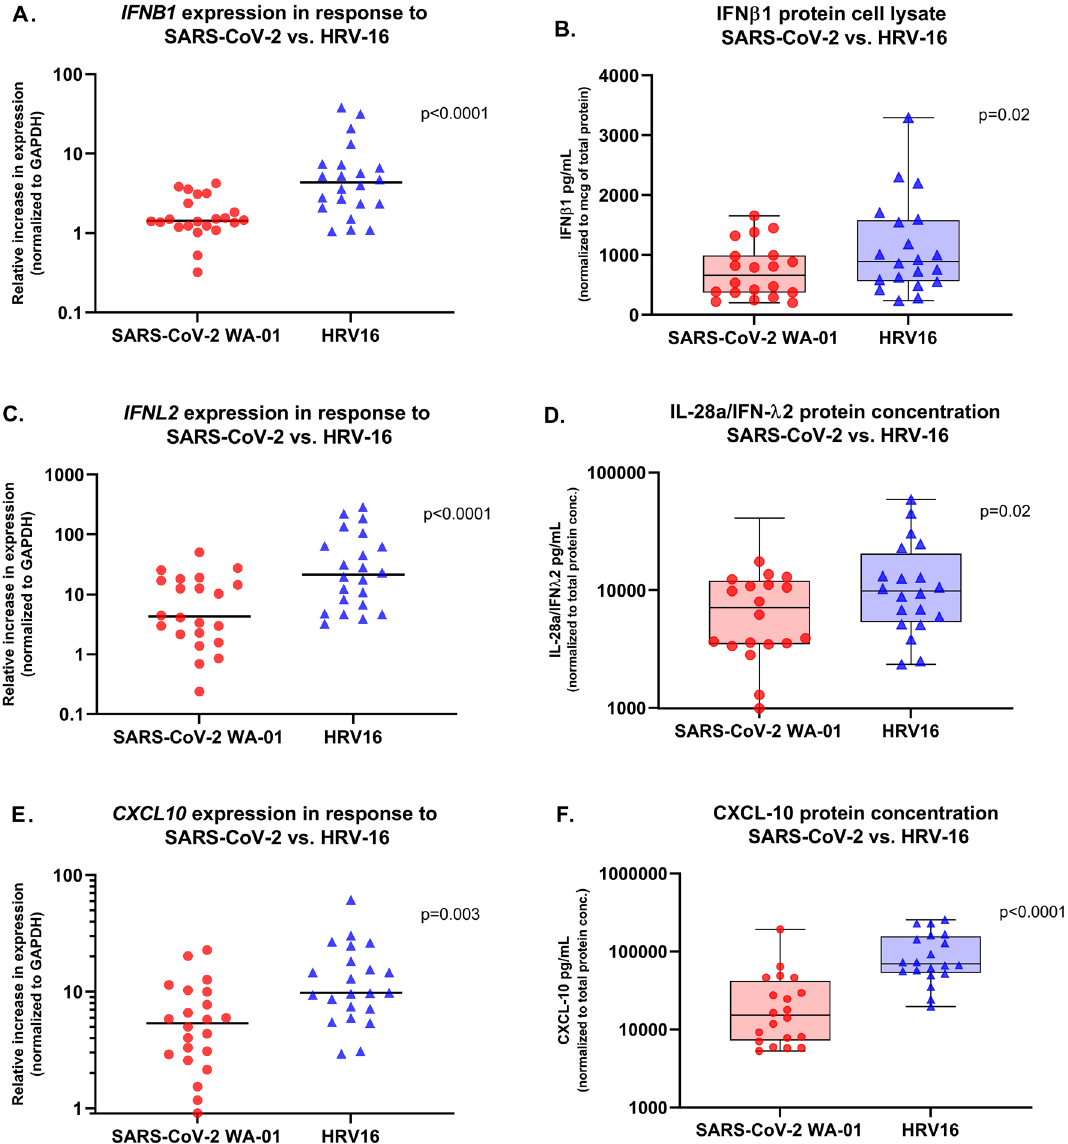
Figure 2. Relative gene expression of IFNB1 , IFNL2, and CXCL10 (normalized to GAPDH expression) by primary bronchial airway epithelial cell cultures in children (n = 14) and adults (n = 8), and parallel IFNβ1, IFN- λ2 (IL-28a), and CXCL10 protein concentrations in cell lysates (normalized to total protein concentration), from primary bronchial airway epithelial cell cultures from children (n = 12) and adults (n = 8) harvested 96 h after SARS-CoV-2 WA-01 (red circles) or HRV-16 (blue triangles) infection. Expression of IFNB1 and corresponding concentrations of IFNβ1 in cell lysates were significantly greater in cultures after infection with HRV-16 than in cultures infected with SARS-CoV-2 [( A ) median increase expression 4.4-fold vs 1.4-fold, p < 0.0001; ( B ) median 892 pg/mL vs 663 pg/mL, p = 0.02]. Expression of IFNL2 , and IFN-λ2 protein concentrations in cell lysates, were significantly greater following HRV-16 infection than SARS-CoV-2 infection [( C ) median increase expression 21.2-fold vs 4.3-fold, p < 0.0001; ( D ) median 9848 pg/mL vs 7123 pg/mL, p = 0.02]. Expression of CXCL10 , and CXCL10 protein concentrations in cell lysates, were significantly greater following HRV-16 infection as compared to SARS-CoV-2 infection [( E ) median increase expression 9.8-fold vs 5.4-fold, p = 0.003; ( F ) 69,306 pg/mL vs 15,232 pg/mL, p < 0.0001]. Analyses by Wilcoxon matched-pairs signed rank test. Bars indicate median values. Boxplots indicate interquartile range and whiskers indicate minimum and maximum